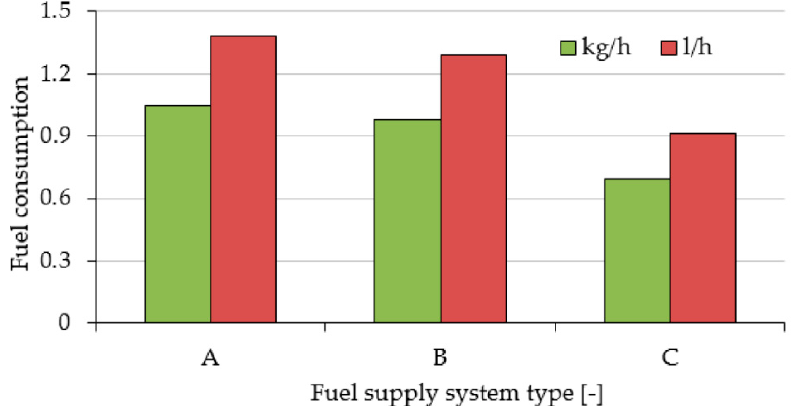
Figure 12. Comparison of fuel consumption from the tested systems: A: Carburettor fuel supply system; B: Injector fuel supply system; C: Injector fuel supply system equipped with an adaptive drive control system.